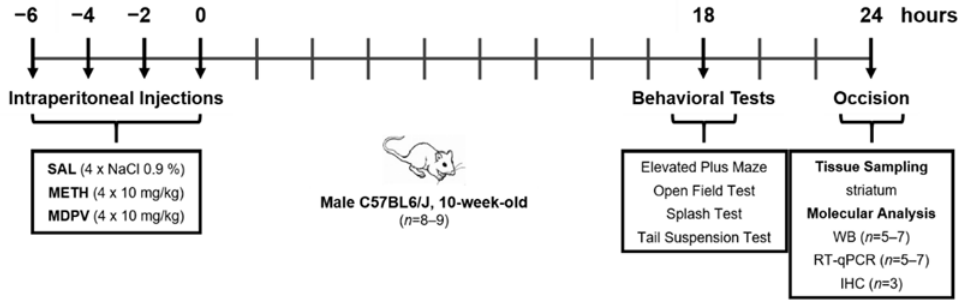
Figure 1. Experimental design. Time course of saline (SAL), methamphetamine ‐ HCl (METH), and 3,4 ‐ methylenedioxypyrovalerone ‐ HCl (MDPV) injections, behavioral tests, occision, and tissue sampling.